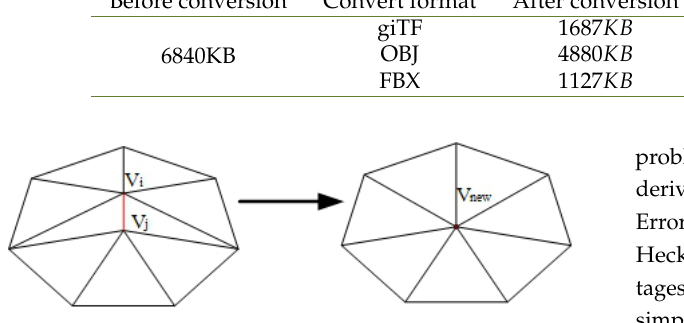
Fig. 4. Schematic diagram of edge